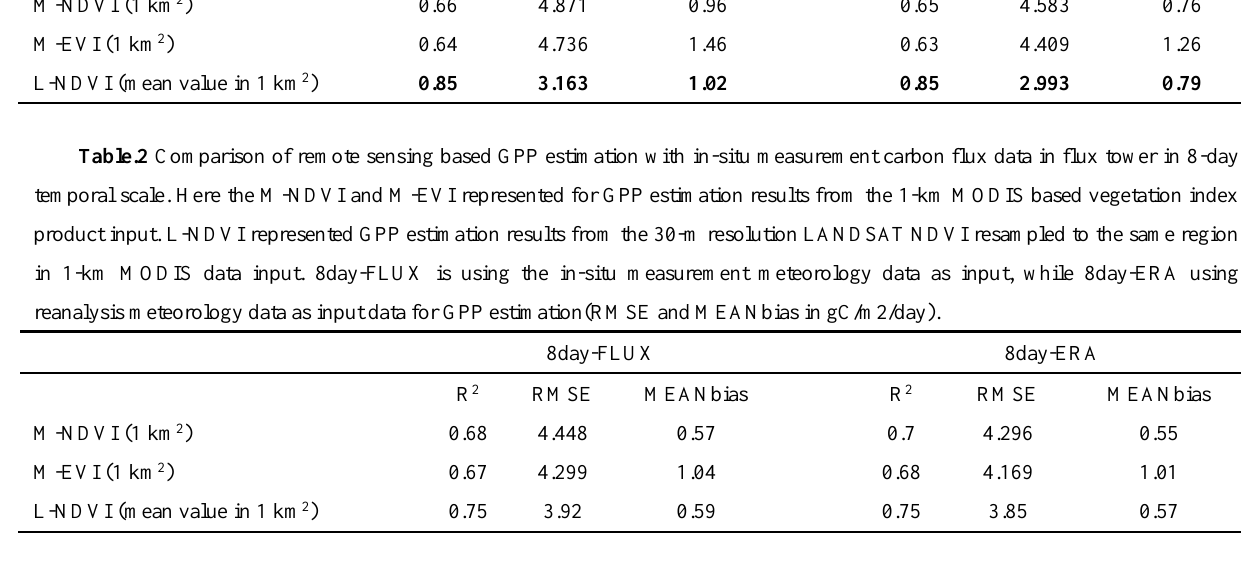
Table.3 Comparison of remote sensing based GPP estimation with in-situ measurement carbon flux data in flux tower in 16-day temporal scale. Here the M-NDVI and M-EVI represented for GPP estimation results from the 1-km MODIS based vegetation